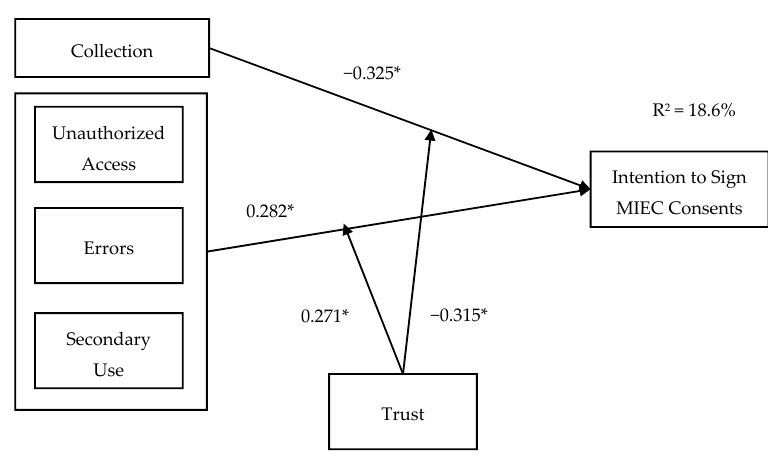
Figure 2. Modified research model. * p < 0.05.